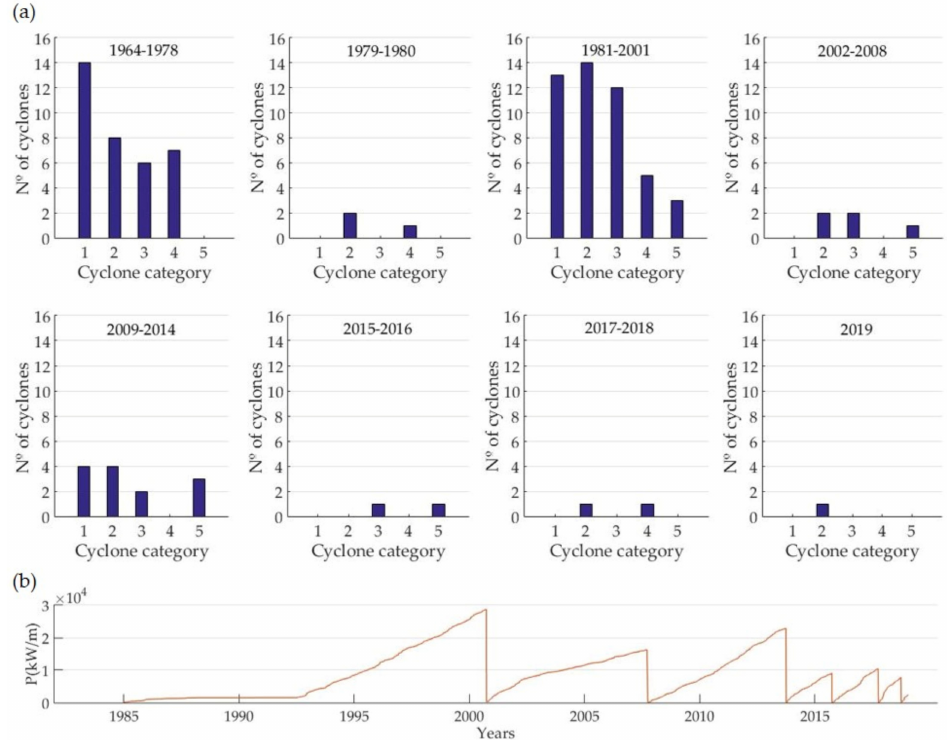
Figure 11. ( a ) Cyclone number and categories, and ( b ) accumulated wave power derived from satellite altimetry during the periods analyzed (additional cyclone information can be found in the Supplementary Materials, Table S1 and Figures